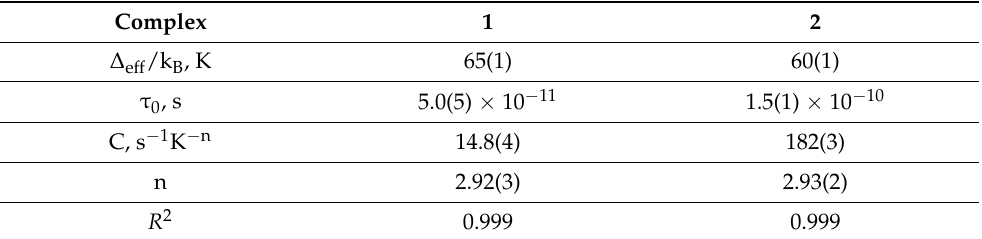
Table 7. Parameters for the magnetic relaxation of complexes 1 and 2 obtained by fitting of the experimental relaxation